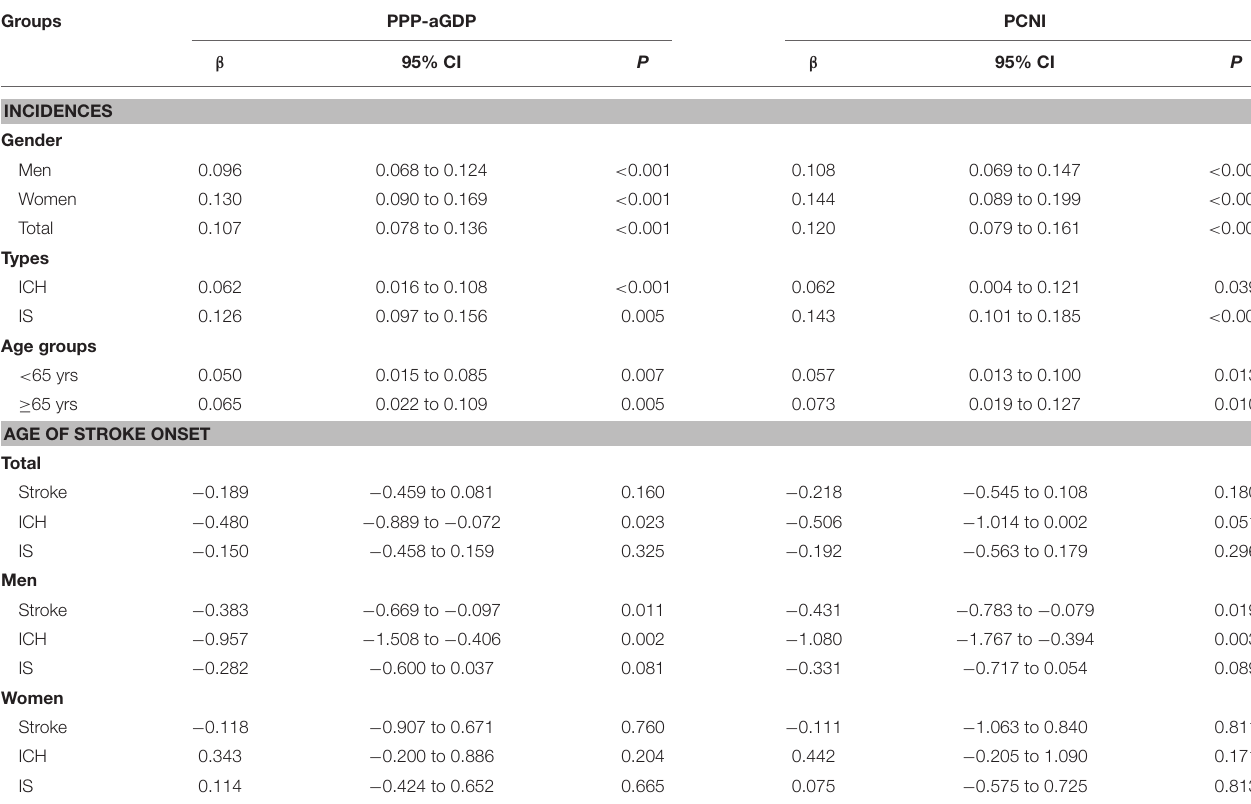
TABLE 4 | The association of stroke incidence with macroeconomic development by sex, age, and subtypes ( β with 95% CI).